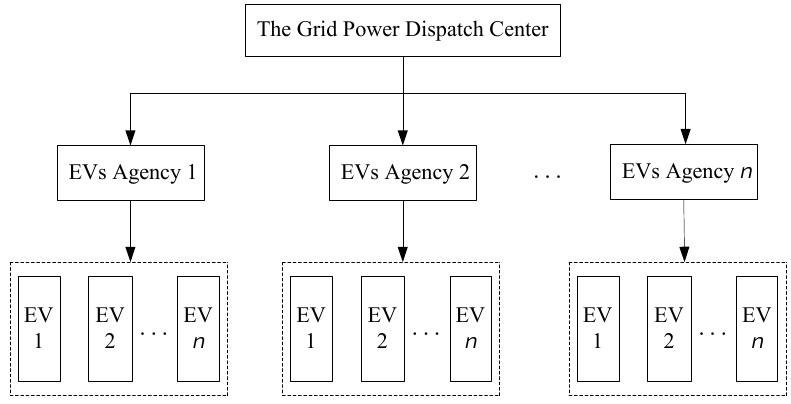
Figure 1. The double ‐ layer dispatch strategy framework.